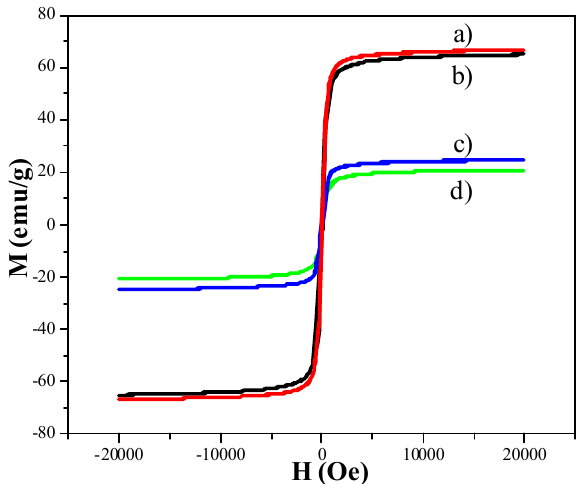
O particles; 3 4 /Fe O 2 3 4